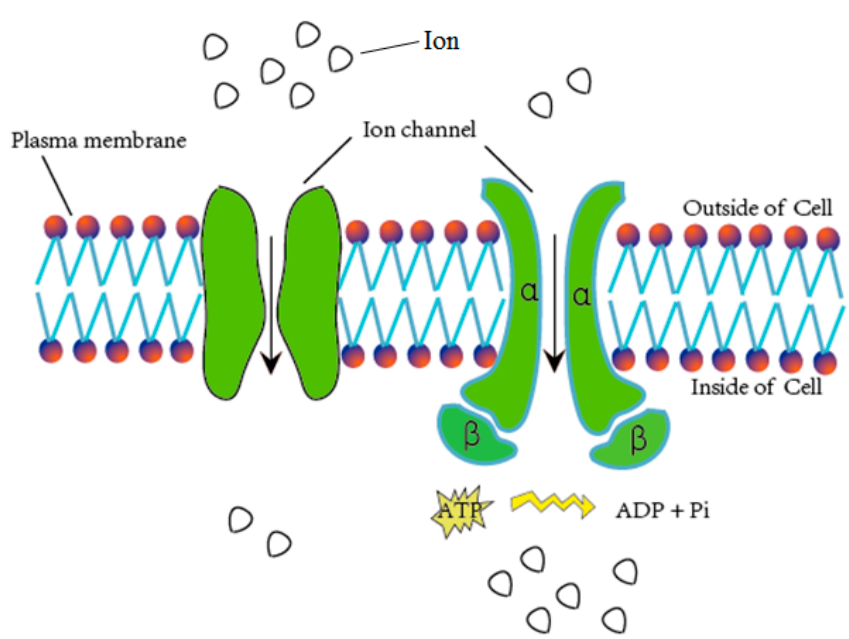
Figure 1. Schematic diagram of material exchange through ion channels.